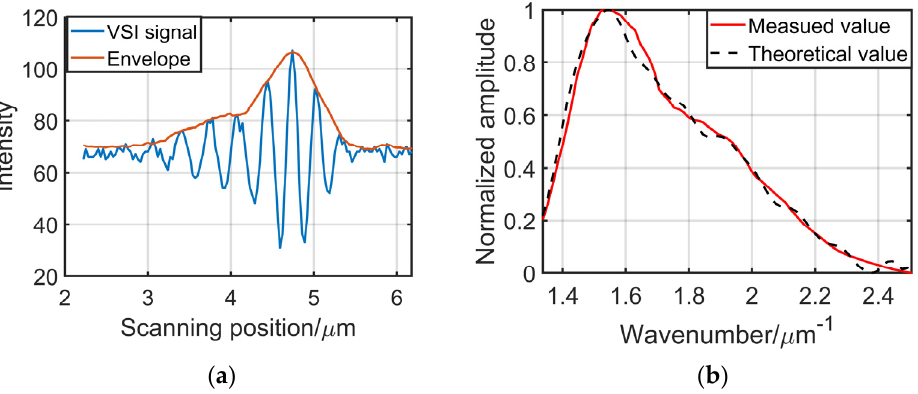
Figure 7. ( a ) VSI signal in area 3 in the time domain. ( b ) Measured (solid red line) and theoretical (dashed black line) Fourier-transform-normalized amplitudes of the VSI signal in area 3. Table 4. Measurement results for thicker films.